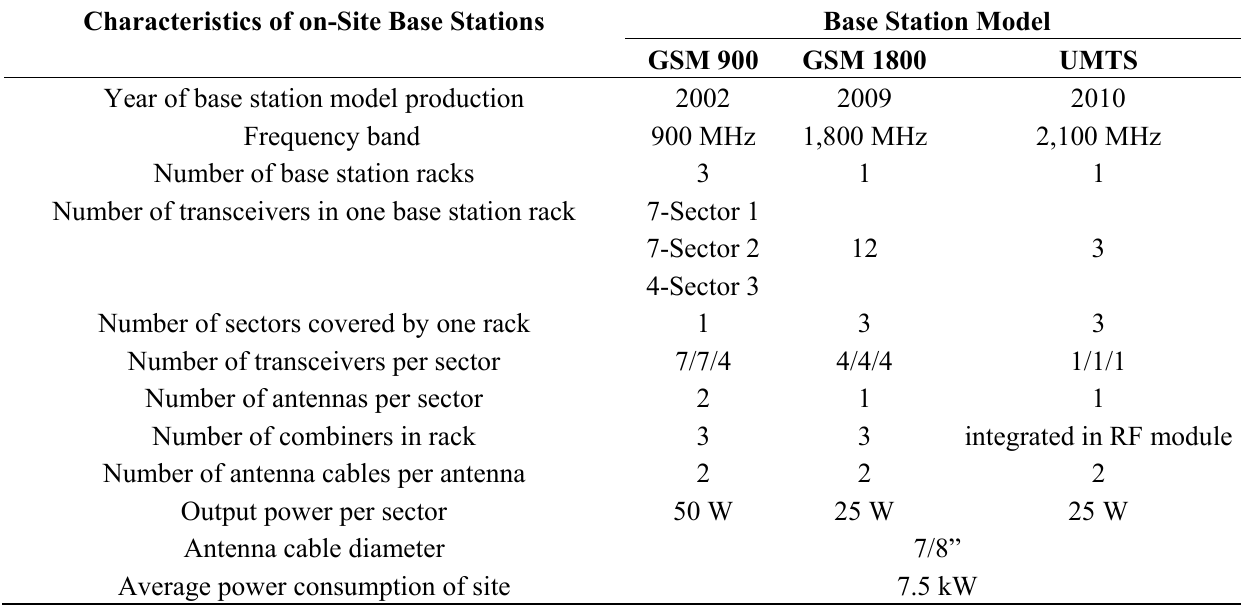
Table 1. Characteristics of base stations installed on analyzed